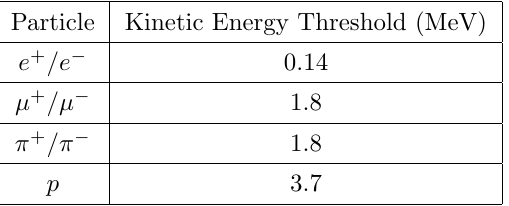
Table 1 . Expected thresholds for track identi(cid:12)cation in gaseous argon, operated at 10 atm. that these are far lower than the thresholds for particle identi(cid:12)cation in the liquid argon near detector